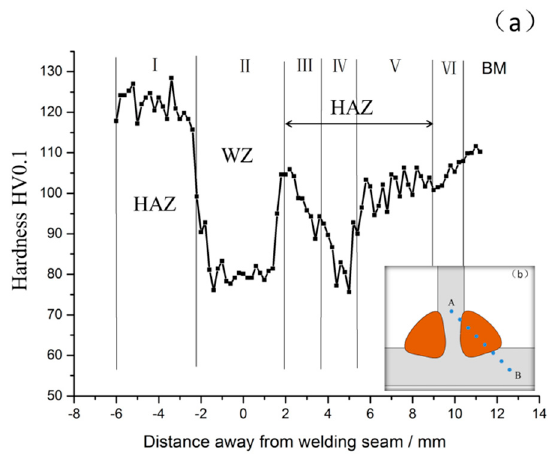
Figure 5. 6082 hardness distribution of T-welded joint of aluminum alloy: ( a ) weld hardness distribution; and ( b ) weld hardness test point.